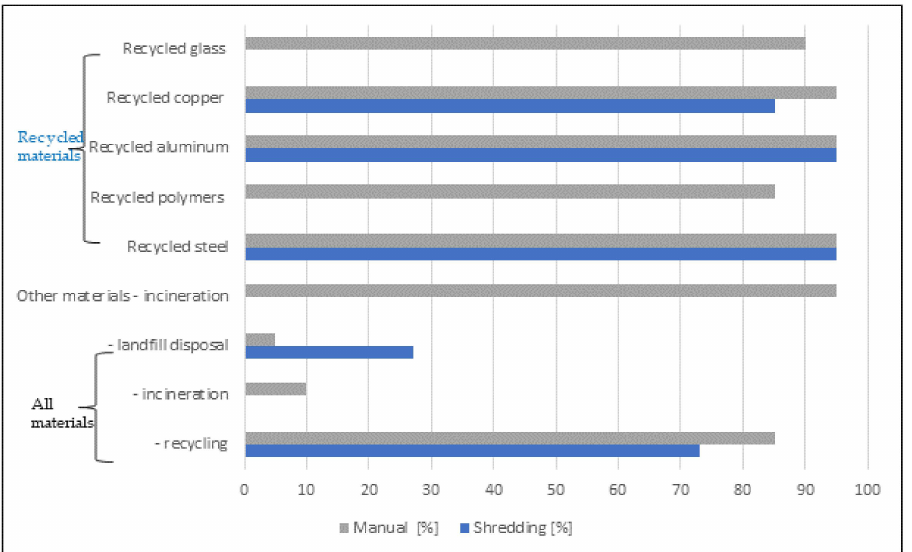
Figure 8. Material recovery rates from ELVs in two scenarios, shredding and manual dismantling, adapted after